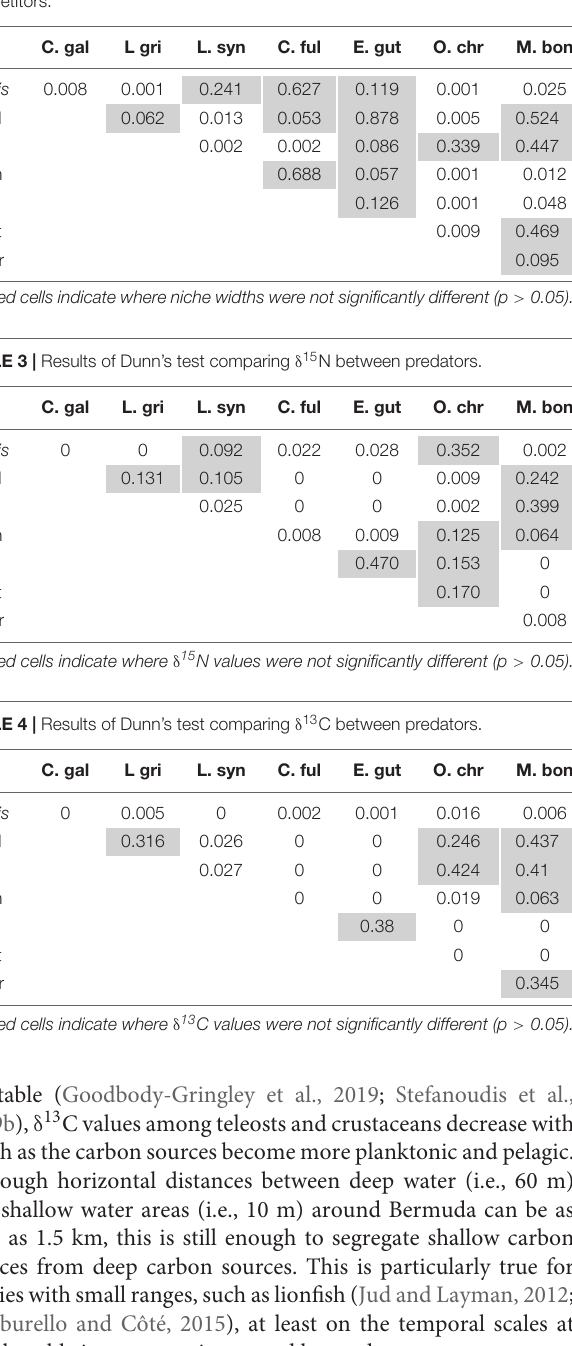
TABLE 2 | Results of Hotelling’s T 2 test comparing niche width between competitors.